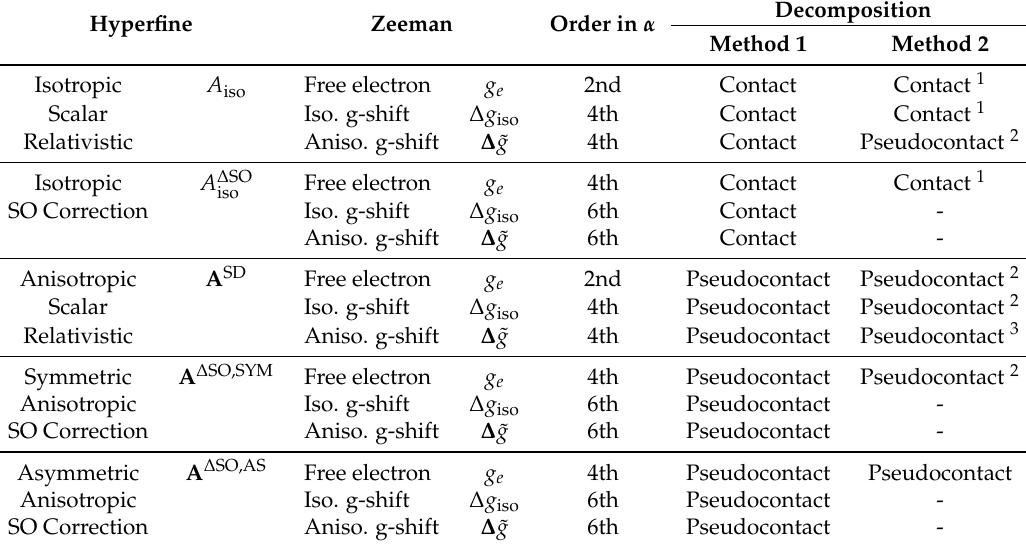
Table 2. Classification of components of the g · A